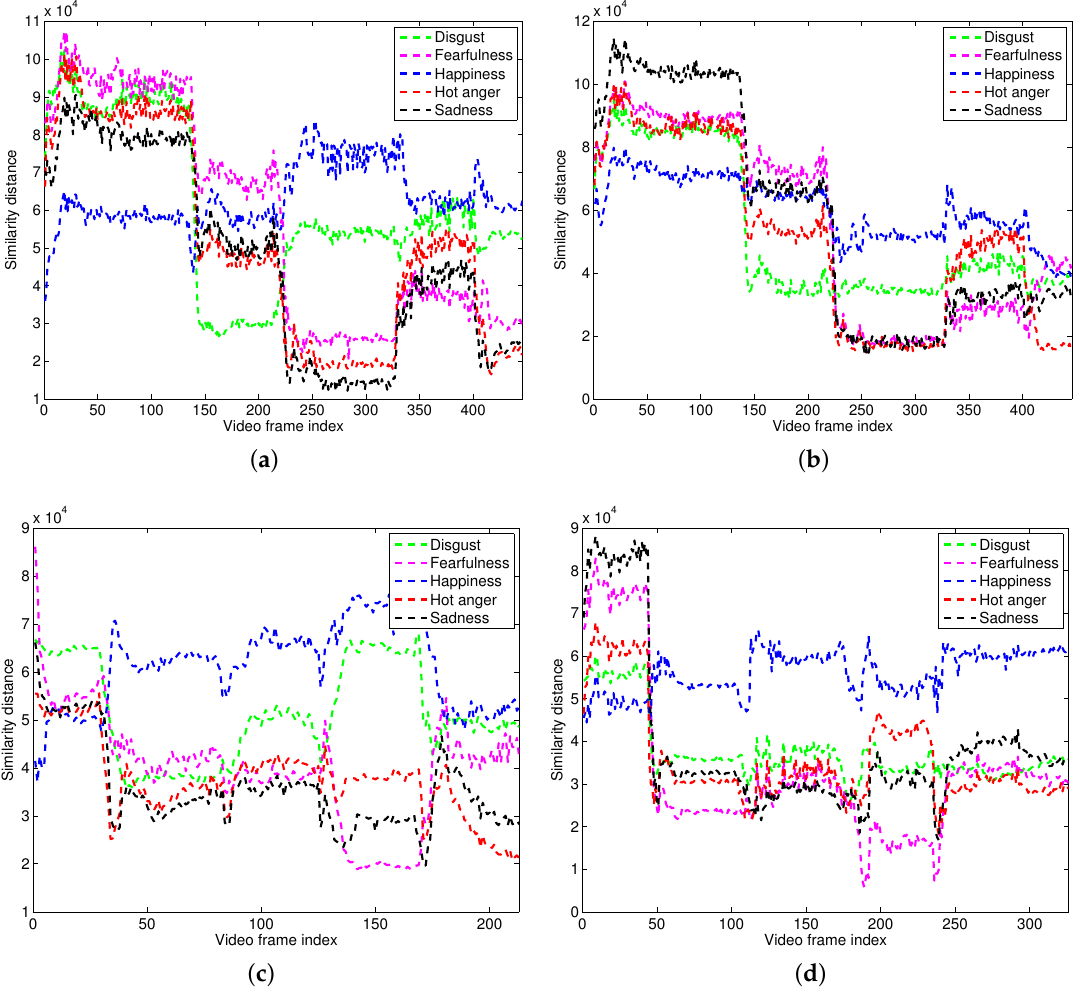
Figure 4. Cross evaluation of different ground truths. ( a ) Configuration 1; ( b ) Configuration 2; ( c ) Configuration 3; ( d ) Configuration